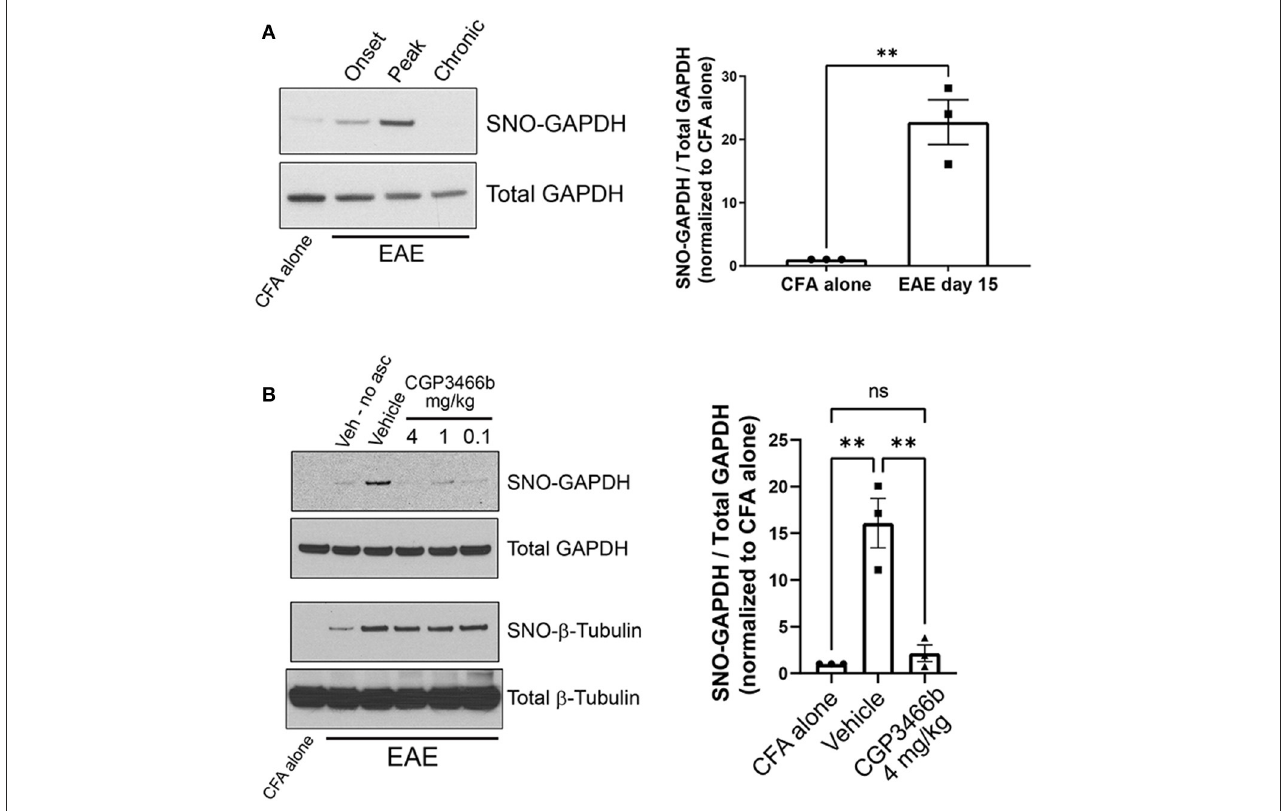
FIGURE1 CGP3466b prevents GAPDH nitrosylation within the CNS in the MOG 35 − 55 EAE mouse model of MS. (A) Nitrosylated GAPDH (SNO-GAPDH) was assayed by biotin switch from spinal cord lysates in control (CFA alone) mice at day 15 and at onset (post-immunization day 10), peak (post-immunization day 15), and chronic (post-immunization day 28) stages of EAE. Total GAPDH in tissue lysate was included as loading control. (Left) Representative immunoblot. ( Right ) Quantification of SNO-GAPDH at peak EAE. The ratio of SNO-GAPDH to total GAPDH band intensity was used for quantification, and results were normalized to CFA alone control. Data represent mean ± SEM of three mice per group. (B) CGP3466b was administered at indicated doses by daily i.p. injection beginning on post-immunization day 0, and nitrosylated GAPDH and β -tubulin were assayed by biotin switch on post-immunization daiy 15. ( Left ) Representative immunoblot. “No asc” = no ascorbate control. ( Right ) Quantification of SNO-GAPDH levels following treatment with vehicle or CGP3466b 4 mg/kg. SNO-GAPDH levels were quantified as described in (A) . Data represent mean ± SEM of three mice per group. ** p < 0.01 by student’s t -test (A) or one-way ANOVA with Tukey’s multiple comparisons test (B) . Full blots are shown in Supplementary Figure